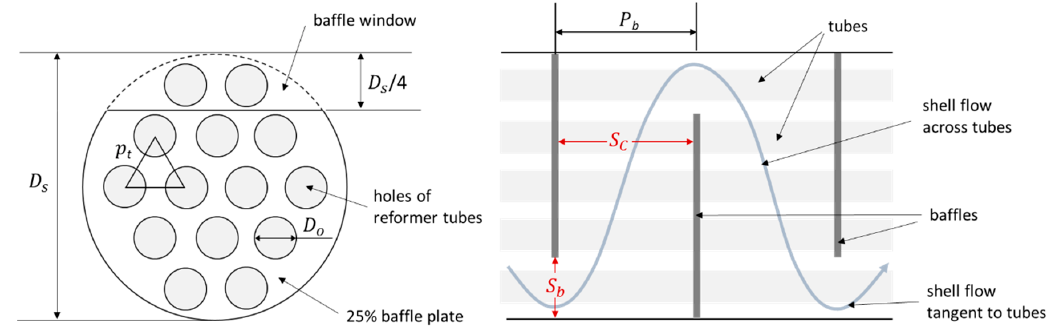
Figure 3. Arrangement of tubes and baffles in the shell of reformer.